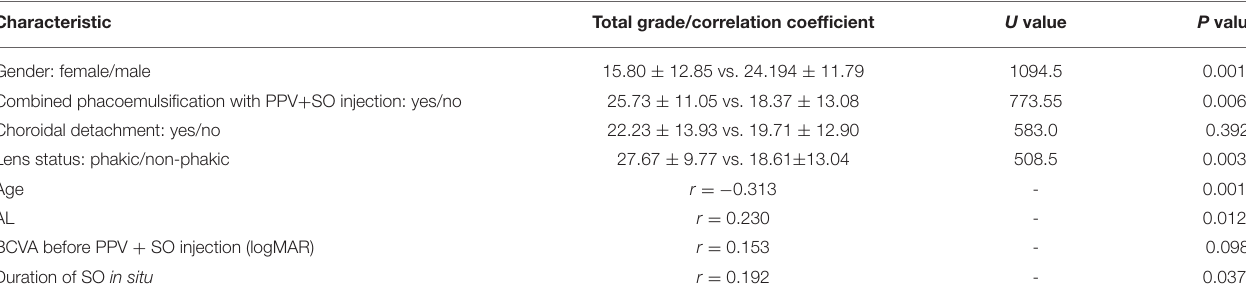
TABLE 1 | Associations between clinical characteristics and total SO emulsification grade. Characteristic Total grade/correlation coefficient U value P